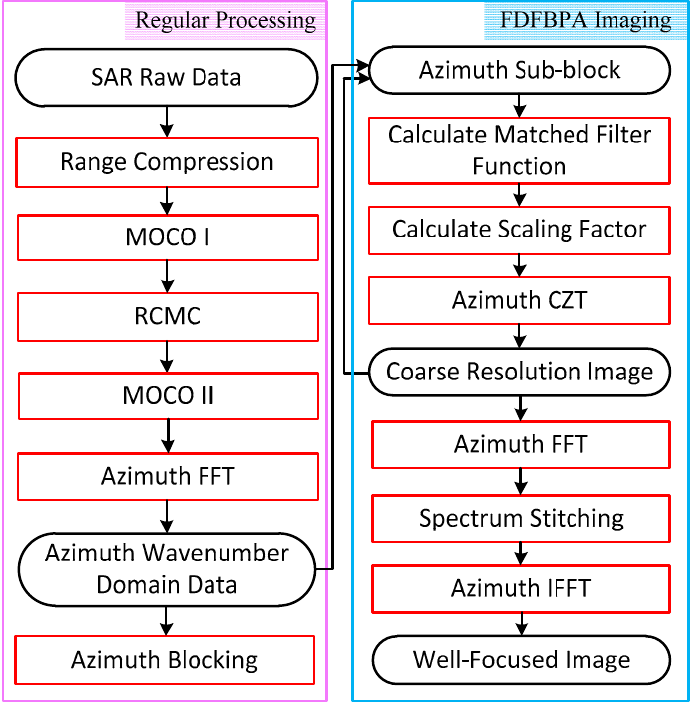
Figure 4. Flowchart of the measured data processing based on FDFBPA.